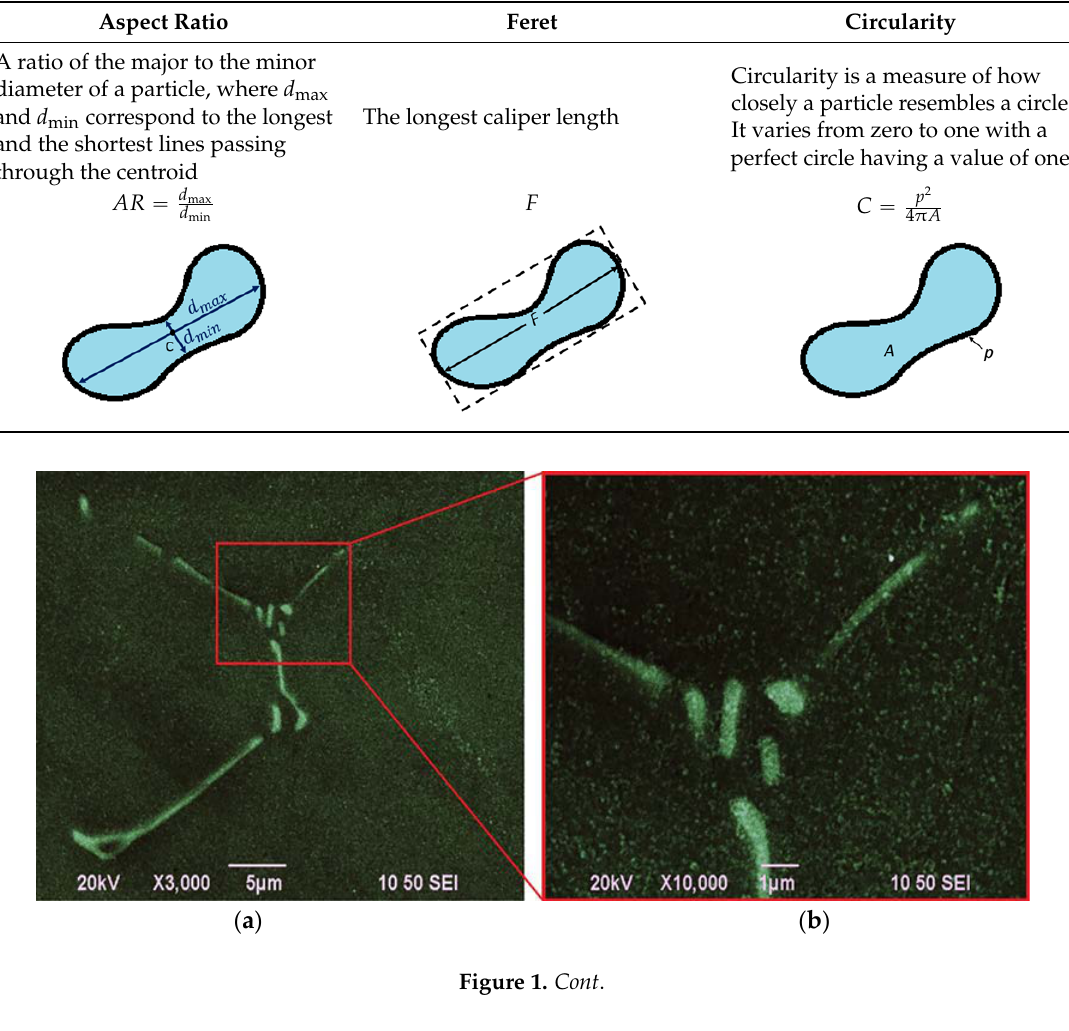
Table 3. The indices employed for the quantification of the homogenization state. Aspect Ratio A ratio of the major to the minor diameter of a particle, Feret Circularity